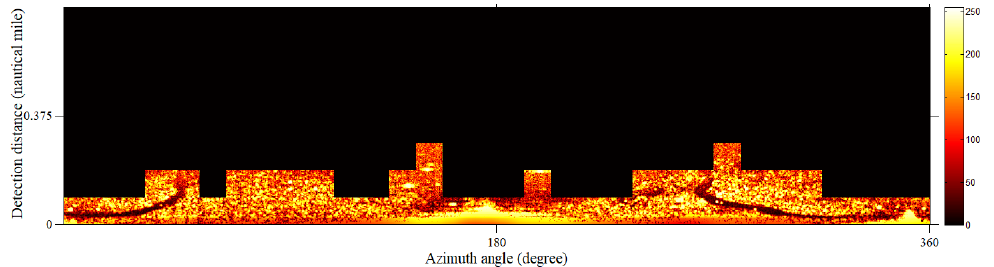
Figure 7. SVM Classification result of effective ocean wave monitoring regions. Some remote mis- classification regions had been deleted.